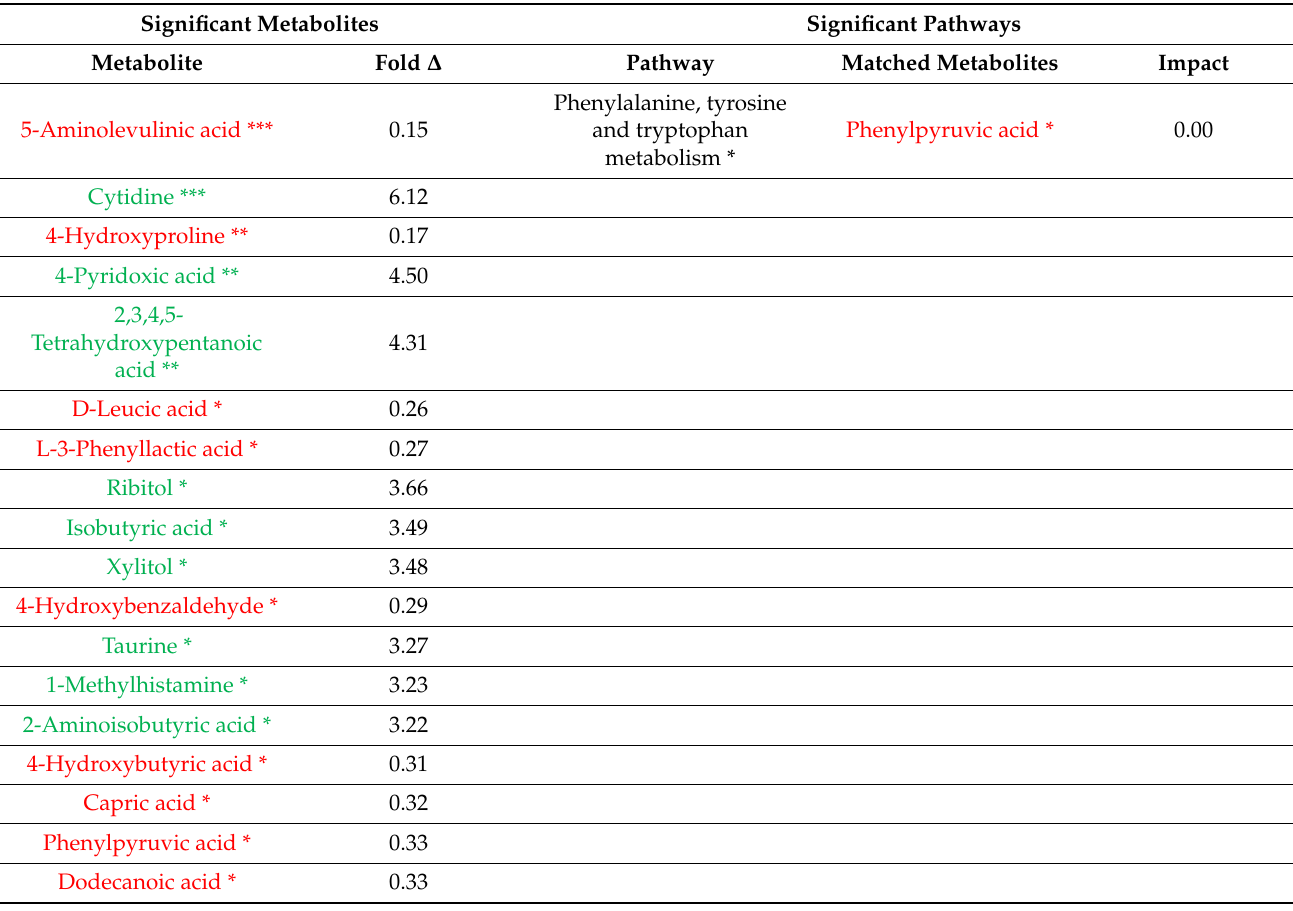
Table 3. Metabolites and their pathways which are different between autism spectrum disorder without neurodevelopmental regression as compared to control